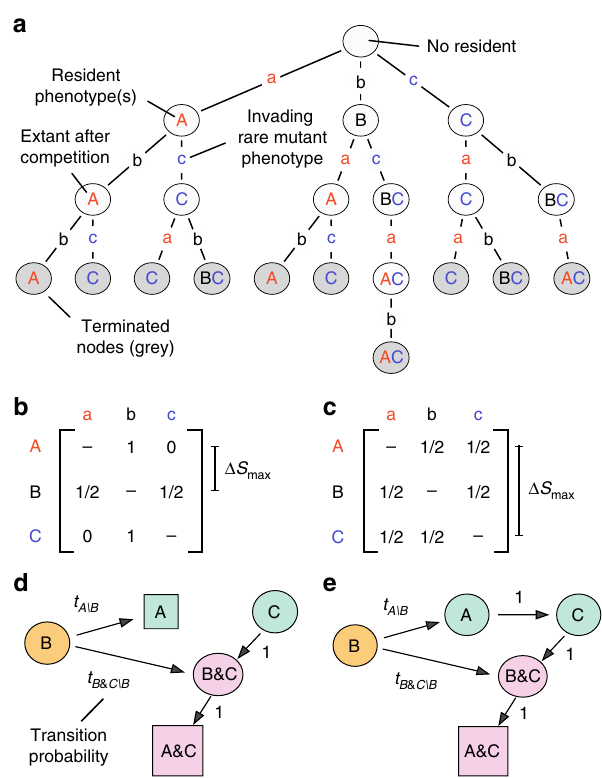
Fig. 2 Generating a Markov process for mutation-limited adaptation. The procedure has two stages: fi rst, simulating all possible ecological invasions; second, calculating the probabilities to transition between steady-states as a result of these invasions. We demonstrate a simple example that has only three possible phenotypes (labeled A , B , and C ). a The invasion map contains the outcome of all possible competitions between residents and mutants and all steady-states. An algorithm based on dynamic programming constructs the invasion map as a tree: nodes represent steady-states connected via edges that represent mutations and competitions. Starting with the empty chemostat (root node), each state is perturbed with a small population of mutants that have each phenotypic value in turn. The steady-state after every competition is recorded in a child node and connected to the parent node. The algorithm dynamically truncates the tree to avoid any recursion (repetition). b To calculate transition probabilities between resident states, we parse the invasion map in a with a mutational process. We assume that mutations are uniformly distributed in the space of phenotypes, but centered on the resident ’ s phenotype and with a maximum size of mutation Δ S max . The elements of the matrix show the conditional probability that phenotype s x generates mutant phenotype s y . c The Markov process in b visualized through a graph of its directed network. States are classi fi ed as either transient ( circles ) or recurrent ( squares ). d , e As in b , c , but with a larger maximum size of mutation Δ S max . The recurrent states, as well as the mutational paths of the process, depend on the distribution of